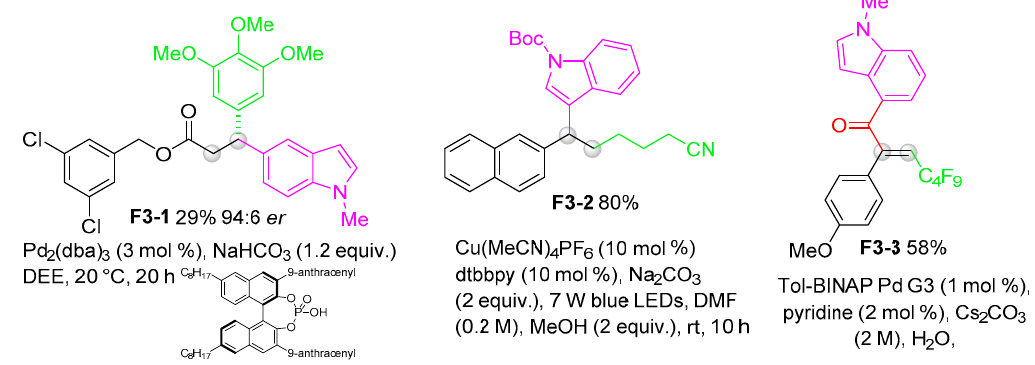
Figure 2. The structures of substances prepared by means of the multicomponent reactions of indolylboronic acids.